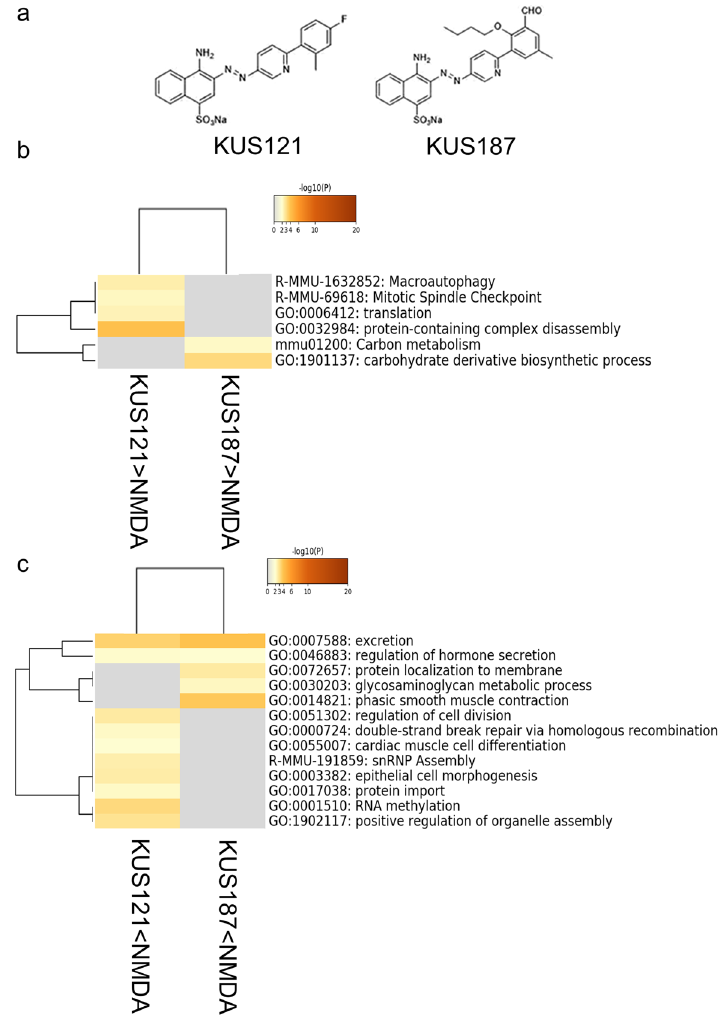
Figure 1. Gene ontology (GO)/pathway analysis of gene clusters. ( a ) Chemical structures of KUS121 and KUS187. ( b ) GO terms and pathways that were significantly related to genes downregulated by NMDA injection and upregulated by KUS treatment. There were no GO terms or pathways which were common between KUS121 and KUS187. ( c ) GO terms and pathways that were significantly related to genes upregulated by NMDA injection and downregulated by KUS treatment. GO terms that were common between KUS121 and KUS187 included excretion (GO: 0007588). KUS121 < NMDA: analysis of genes that were upregulated in NMDA-injected mice retina and downregulated by KUS121 treatment, KUS187 < NMDA: analysis of genes that were upregulated in NMDA-injected mice retina and downregulated by KUS187 treatment, KUS121 > NMDA: analysis of genes that were downregulated in NMDA-injected mice retina and upregulated by KUS121 treatment, KUS187 > NMDA: analysis of genes that were downregulated in NMDA-injected mice retina and upregulated by KUS187